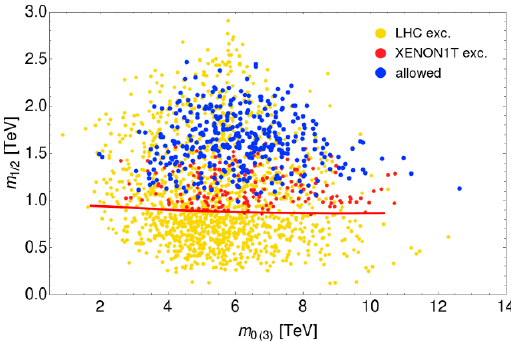
(a) We show regions of (cid:1) EW > 30 (blank) and CCB minima (lower left) in the scalar poten- tial. The blue points are LHC Run 2 and DM- allowed. Figure 4. Locus of n = 1 landscape scan points in the (a) m 0 (3) vs. A 0 and (b) m planes for the NUHM3 model with (cid:22) = 100{360